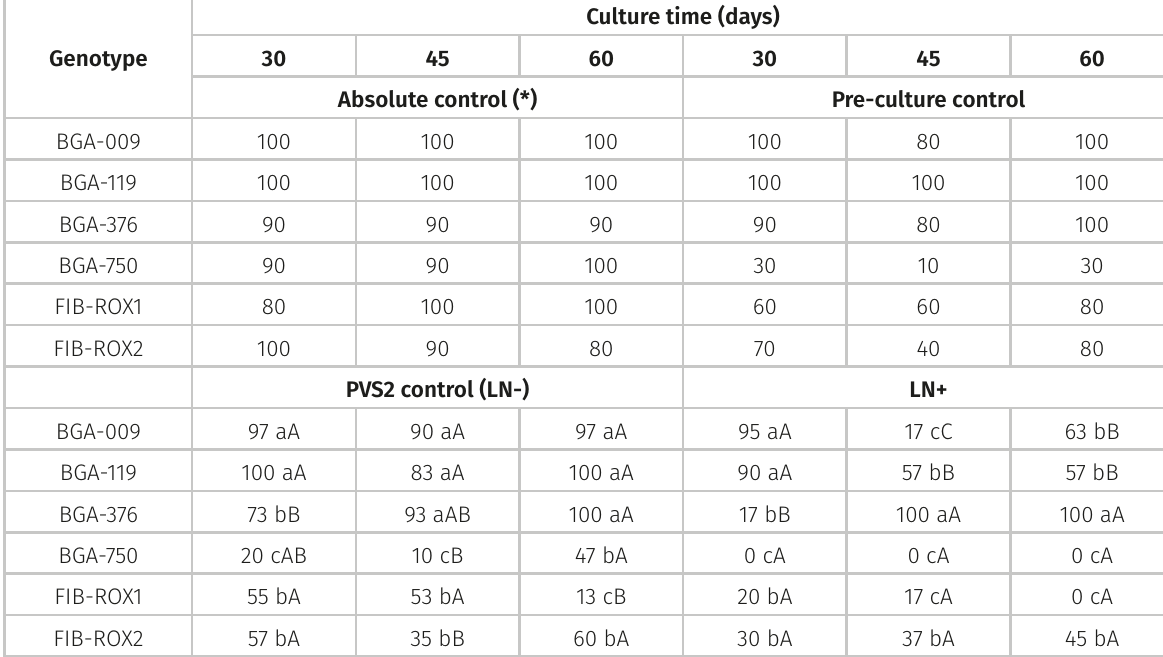
(*) Culture of shoot tips without pre-culture and PVS2 exposure; Means followed by the same lowercase letters in the column within the same factor (LN - and LN + ) belong to the same group by the Scott-Knott test at 5% probability, and those followed by the same uppercase letters in the rows do not statistically differ by the Tukey test at 5%